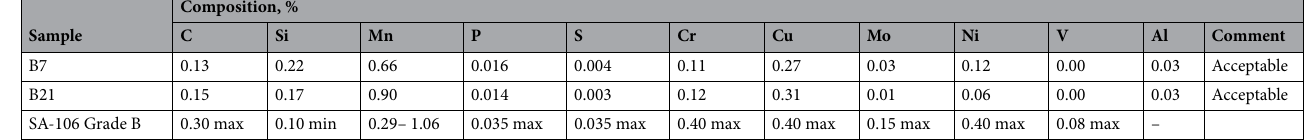
Table 3. Chemical composition of the investigated pipes. The sum of Cu, Ni, Cr, Mo and V shall not exceed 1.00%.